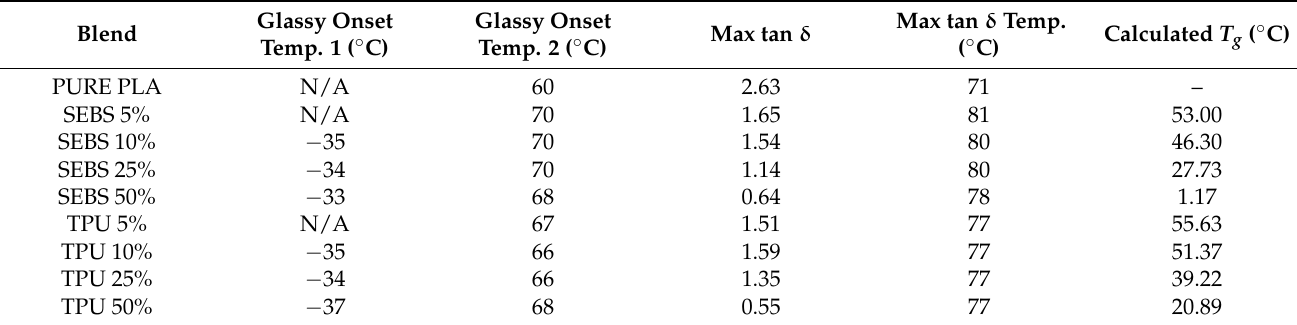
Figure 4. Example of determination of the thermal schedule for shape memory property characterization, in this case, for PLA. Table 3. Glassy onset temperatures and maximum loss tangent values.